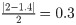
Relationship between quality of estimated allelic dosage from IMPUTE2 imputation and predictors of imputation quality.Data are estimated from 10% of the original chip (59808 SNPs) masked from imputation. Discordance of predicted allelic dosage (y axis) is the fraction difference between dosage computed from imputation probabilities and dosage based on masked genotype data: for example, if the true genotype is reference homozygote and the allelic dosage from imputation is 1.4, the discordance is |2-1.4|2=0.3. Left panel: imputation quality greater than 0.9; right panel: quality between 0.8 and 0.9. Clusters correspond to minor allele frequencies of 10%; individual bars represent quality stratified by masked genotype. “Predicted” bars correspond to expected concordance assuming independence of individual haplotypes. Error bars represent 95% confidence intervals of mean discordance estimate.